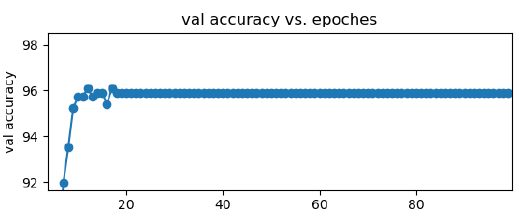
Figure 8. Zoomed in on the accuracy of the validation set (ACC: 0.9591).